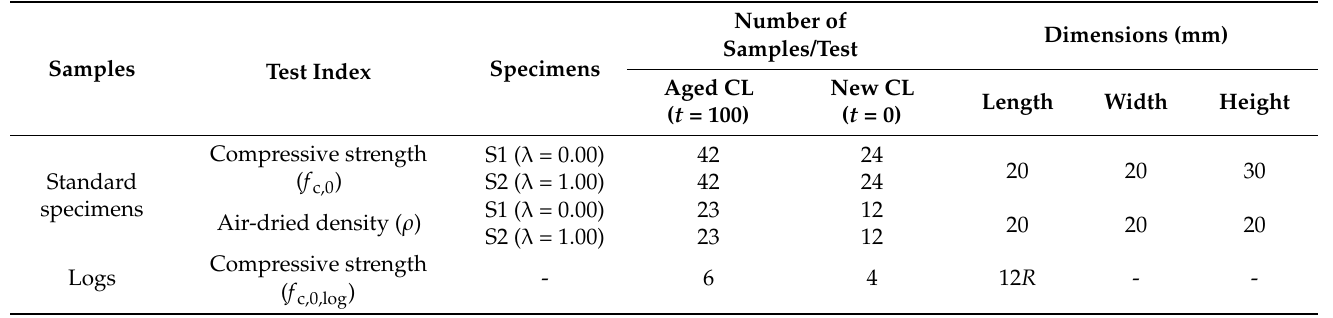
Table 2. Number of samples and their dimensions for each type of